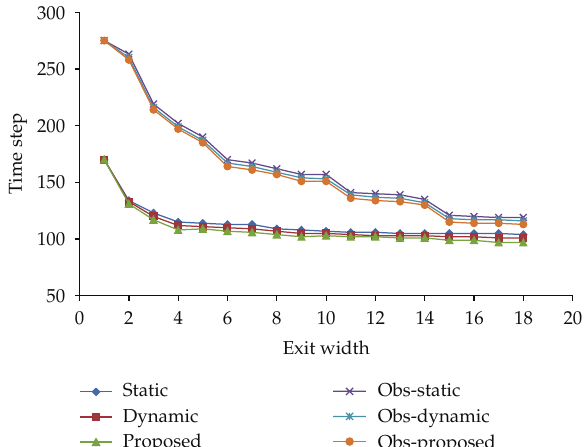
Figure 16: Variation in evacuation time (cid:2) in time steps (cid:3) with increasing exit width in the restaurant shown in Figure 12.